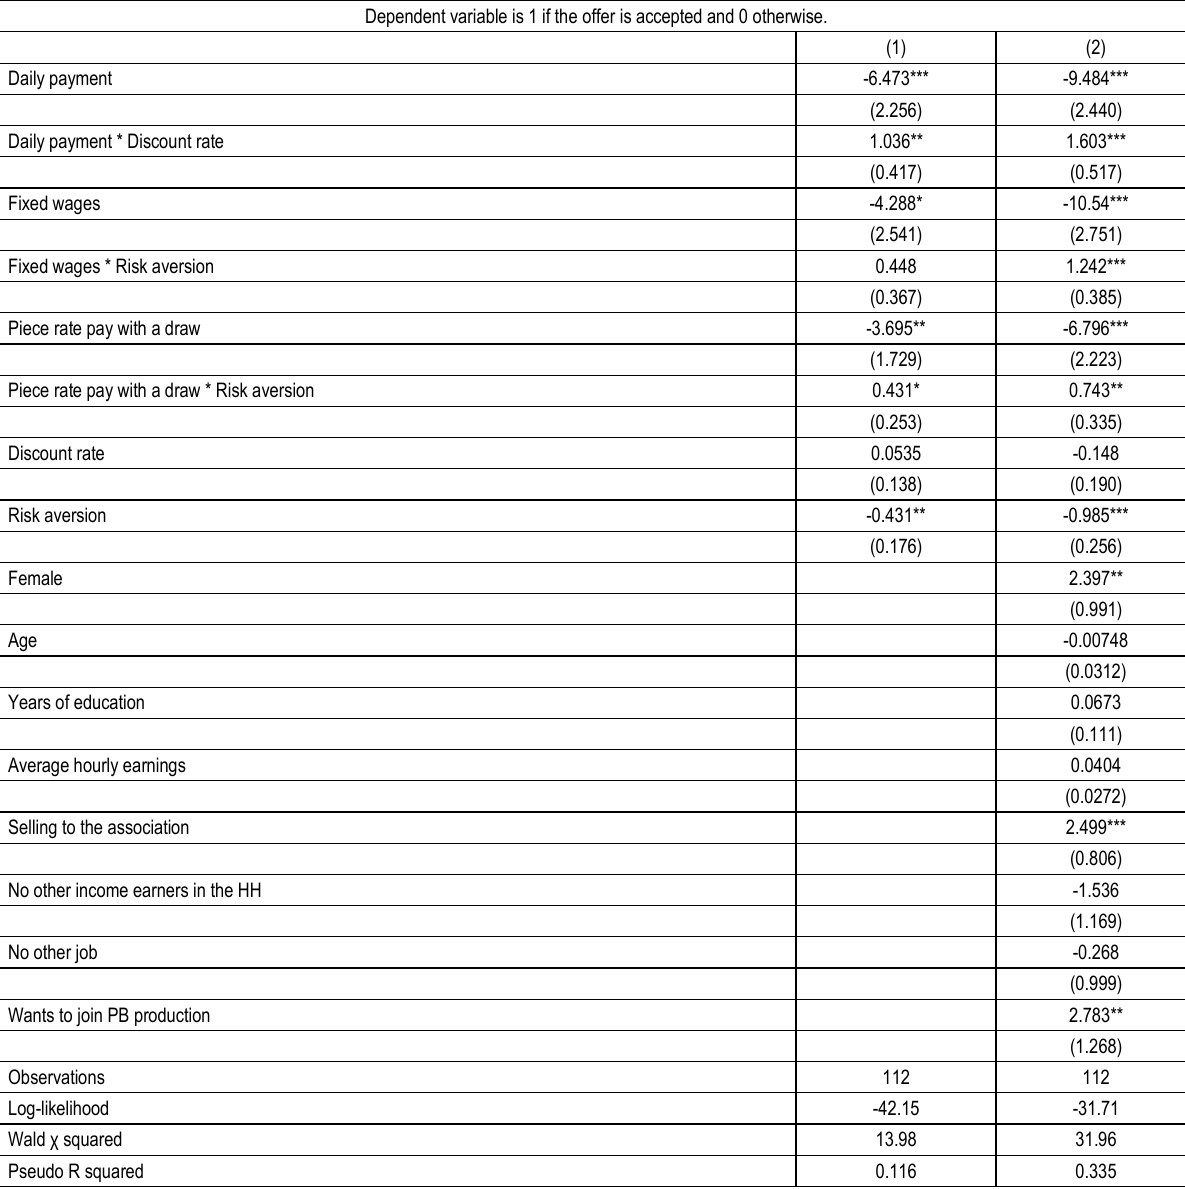
Table 4. Accepting a job offer with interaction terms: coefficients (logit estimations) Dependent variable is 1 if the offer is accepted and 0